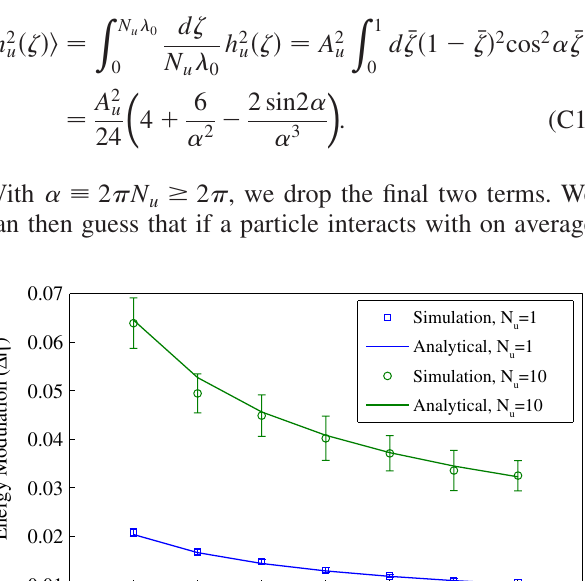
(cid:10) for N u ¼ 1 and 10, and 0 0